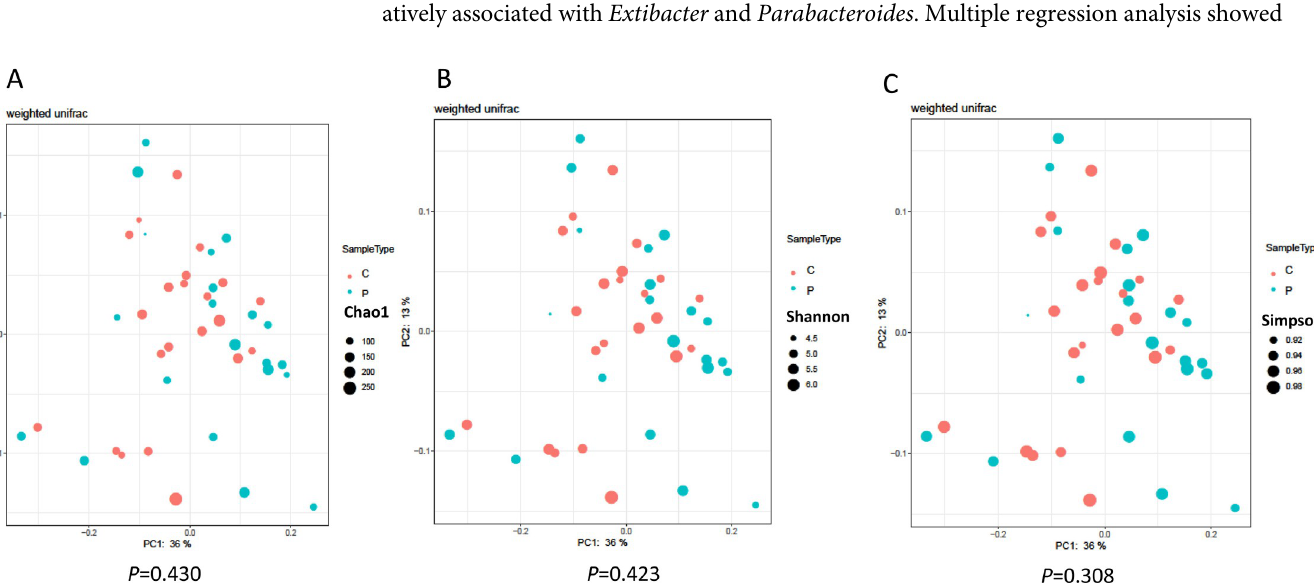
Fig 2. Principal coordinates analysis plot comparing sample distribution between the PMDs group and the control group. Each blot shows data for alpha diversity, the Chao 1 index (A), the Shannon index (B), and the Simpson index (C). Abbreviations: C, control group; P, premenstrual disorders